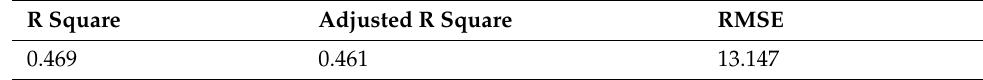
Table 5. Indexes for the goodness of fit for the fitted BMLR models. R Square